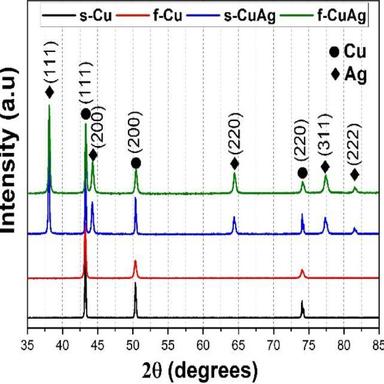
XRD pattern of s-Cu, f-Cu, s-CuAg and f-CuAg powders.